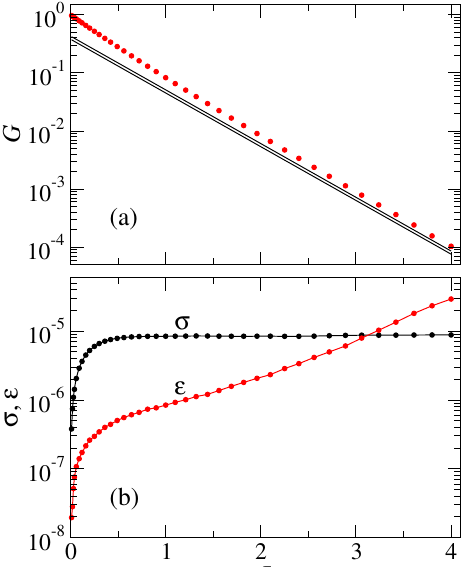
FIG. 22. (a) Imaginary-time correlation function at q ¼ ð π ; 0 Þ for a 2D Heisenberg lattice with L ¼ 48 , computed in SSE QMC simulations at β ¼ 192 (giving T ¼ 0 results for all practical purposes). The two straight lines correspond to the contribution from the leading δ function obtained in the SAC procedure, with amplitude a 0 ¼ 0 . 405 (cid:3) 0 . 025 . (b) The statistical errors (diago- nal elements of the covariance matrix) σ ð τ Þ and the eigenvalues of the covariance matrix (ordered from smallest to